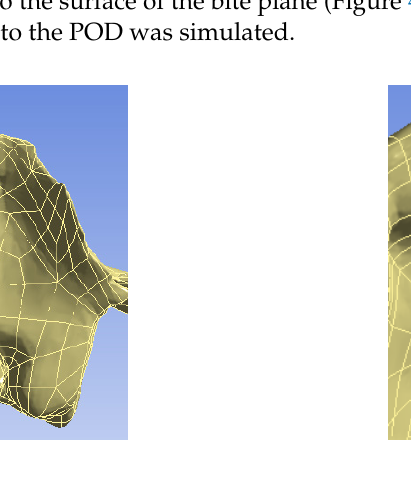
Figure 4. Applied load of 100 N: ( a ) force magnitude and direction; ( b ) force application area.